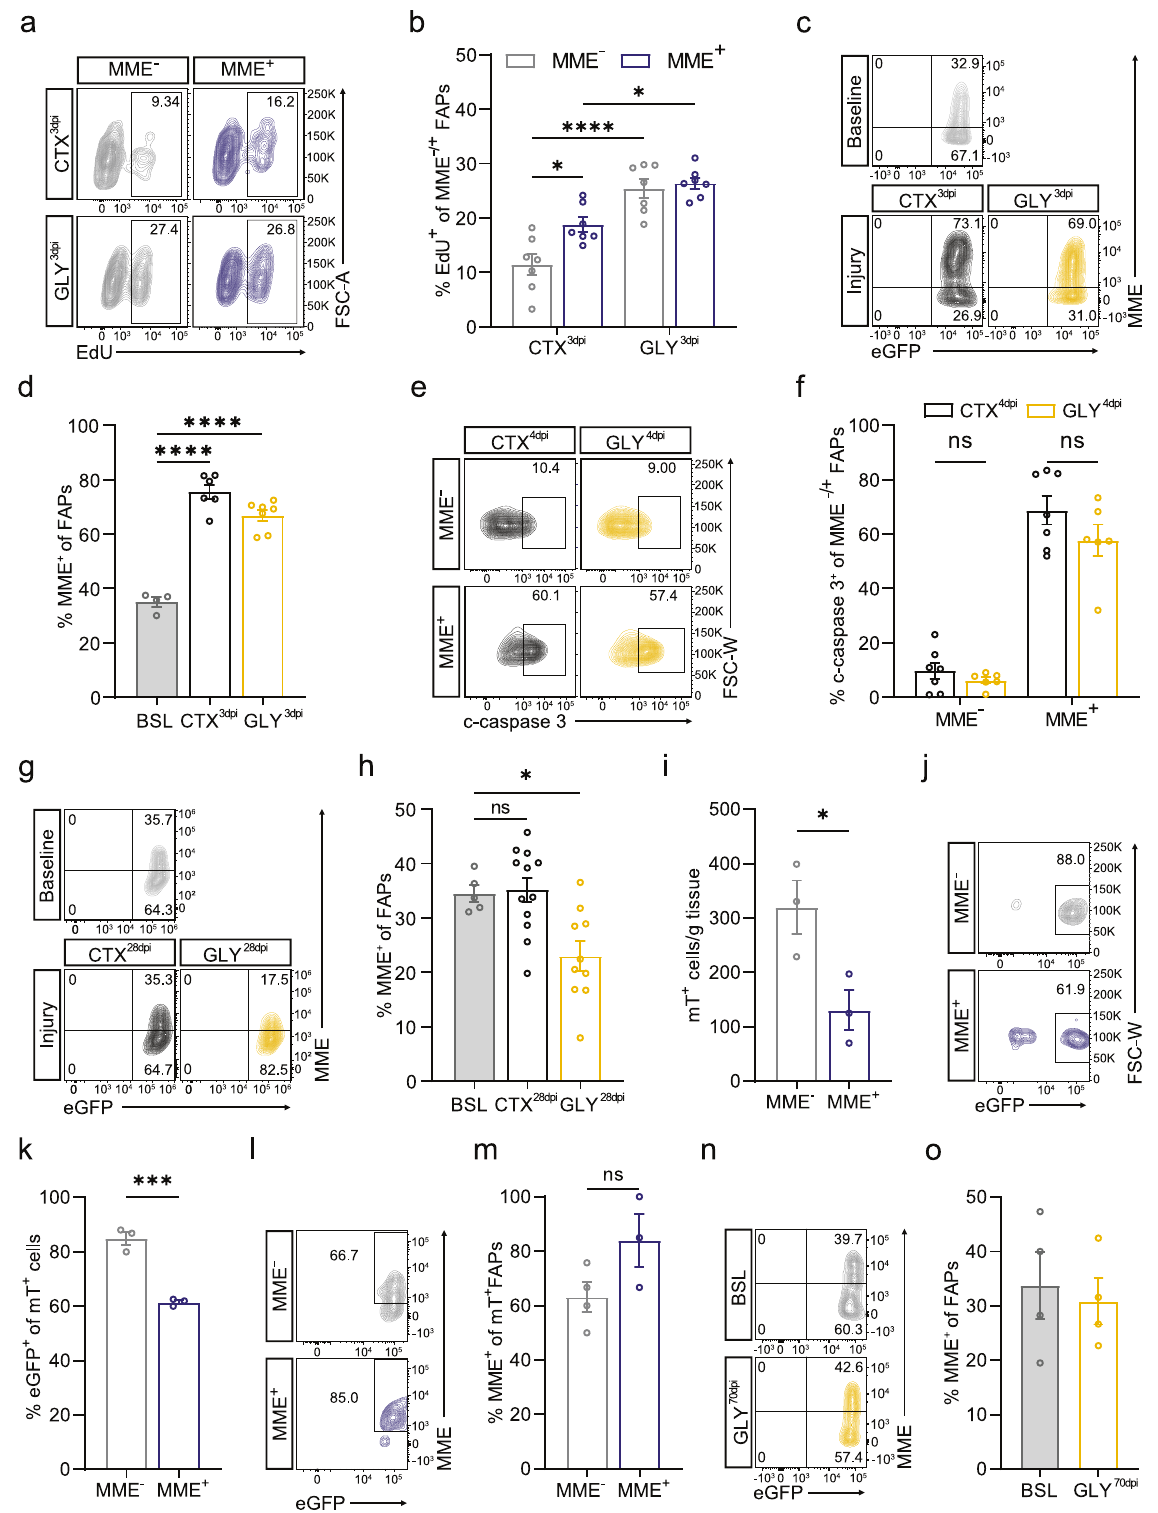
datasets were integrated and batch-effect corrected using Harmony 50 . We aimed at identifying which cell populations differed in the GM highFI muscle as compared to the RF ctrl muscle and found signi fi cant changes in the distribution of the different cell populations across each dataset. Along with a robust increase in the fractional abundance of immune cells in the GM highFI muscle (Supplementary Fig. 8b), we found that the total number